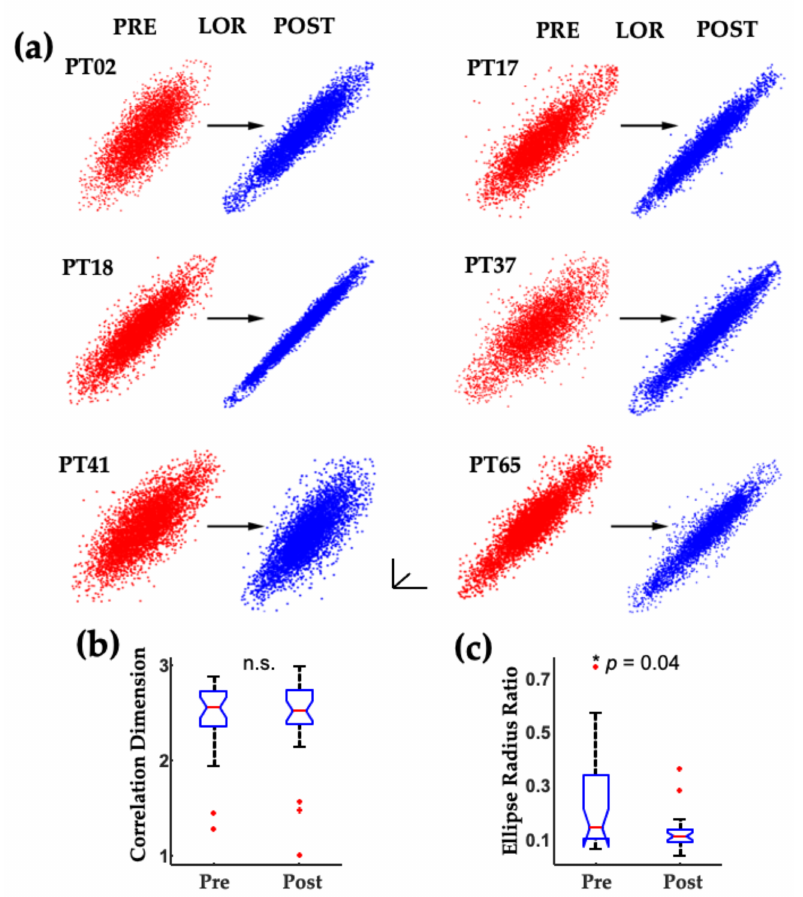
Figure 13. Consistent changes in geriatric patient EEG attractors occur with a loss of response. ( a ) Attractors generated from 20 s clips of EEG activity from before (red) and after (blue) loss of response (LOR) show consistent flattening and more ellipsoidal shapes following LOR. ( b ) Correlation dimension attractor measure did not capture the change in activity following LOR. ( c ) However, the geometric phase–space measure (ellipse radius ratio) significantly decreases following LOR. Attractors are auto-scaled to illustrate the shape changes that occur with LOR. The axes are shown to demonstrate that these are 2D projections of 3D attractors. The * indicates significance for the Holm– Bonferroni corrected p -value shown here, n.s. indicates a not significantly different comparison. Adapted with permission from reference